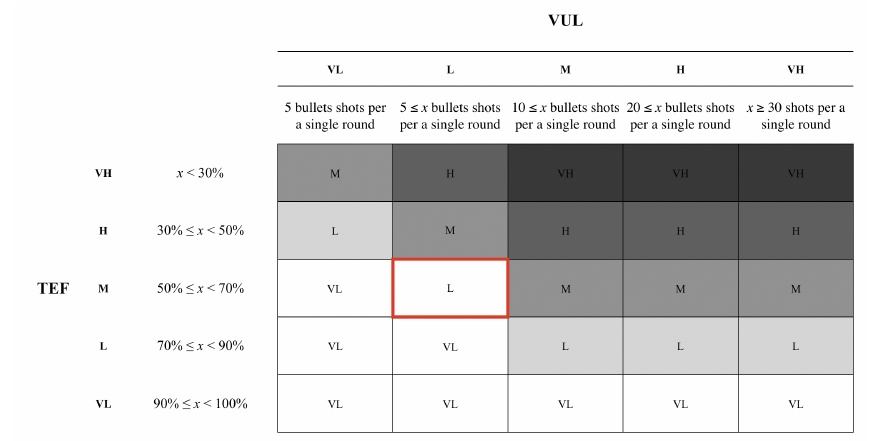
Figure 6. The heat map for Map2 scored a ‘Low’ grade based on the participants’ response on the Threat Event Frequency (TEF) and Vulnerability (Vul).